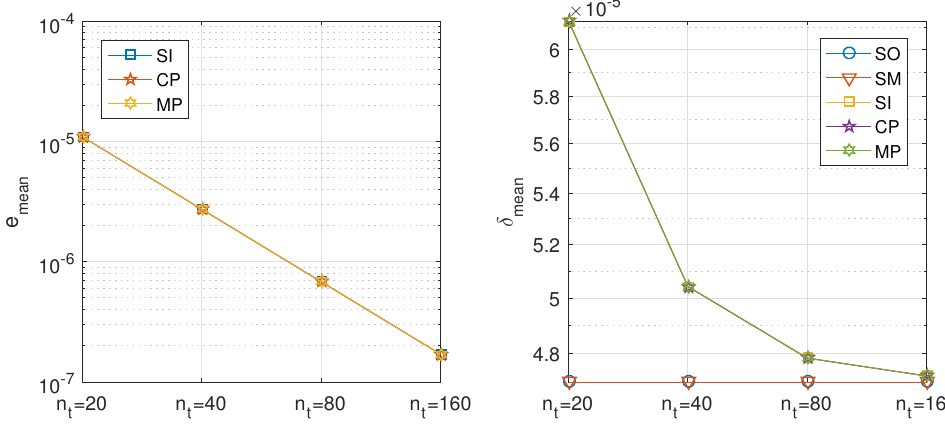
Figure 3. Diffusion problem, directional decomposition. Precision of the proposed methods: sequential iterative SI, classical parallel CP, and modern parallel MP, compared with the classical ones: sequential operator SO and Strang–Marchuk SM, with fourth order approximations for the spatial derivatives for different number of time